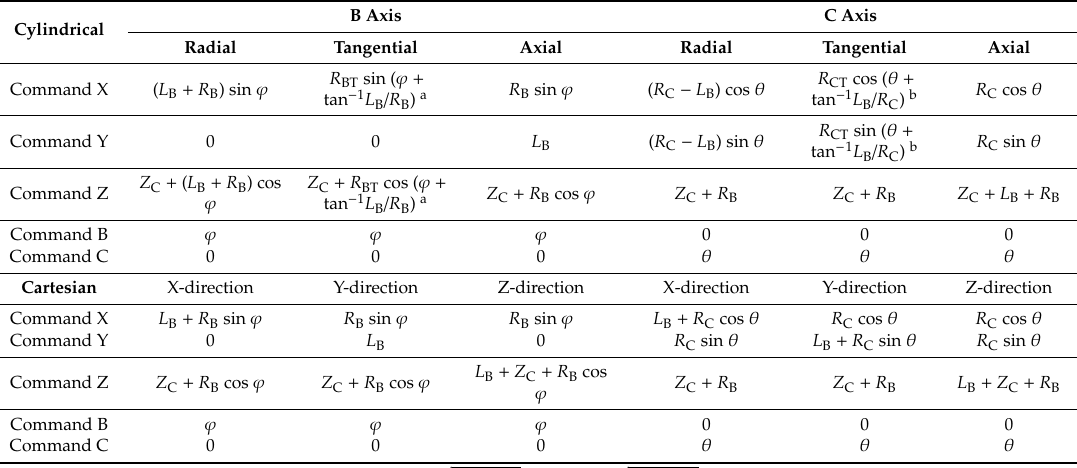
Table 2. Commands given to each axis during